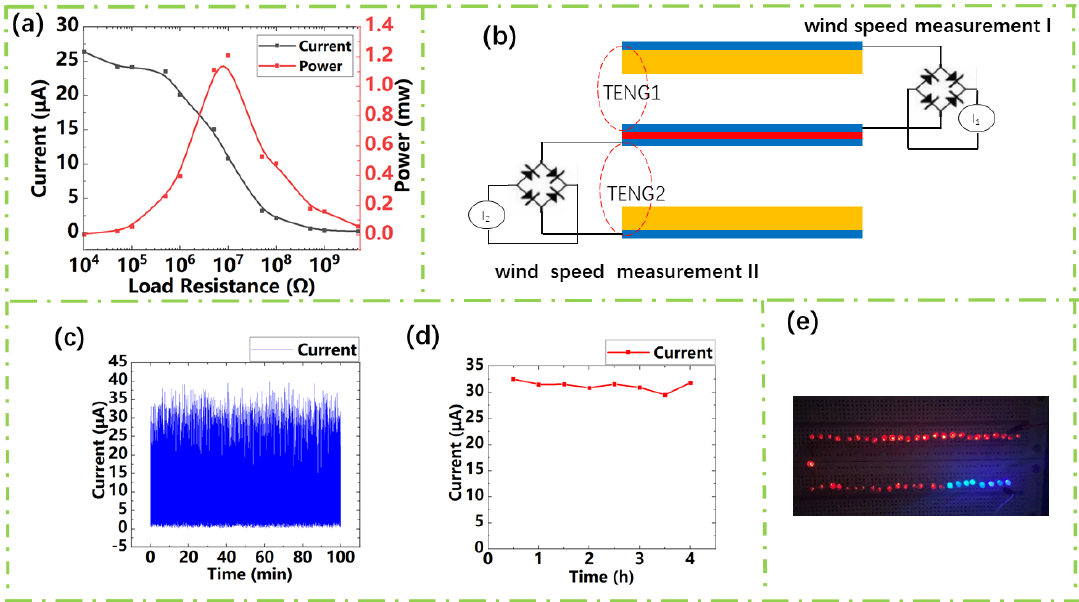
Figure 5. ( a ) Dependence of TENG output current/power on external resistance. ( b ) Circuit design diagram of a sensor for speed measurement. ( c ) The current output of the wind speed sensor lasts for 100 min under the wind speed of 25 m/s. ( d ) The current output of the wind speed sensor lasts for 4 h under the wind speed of 25 m/s. ( e ) The actual picture of TENG powering the LEDs.